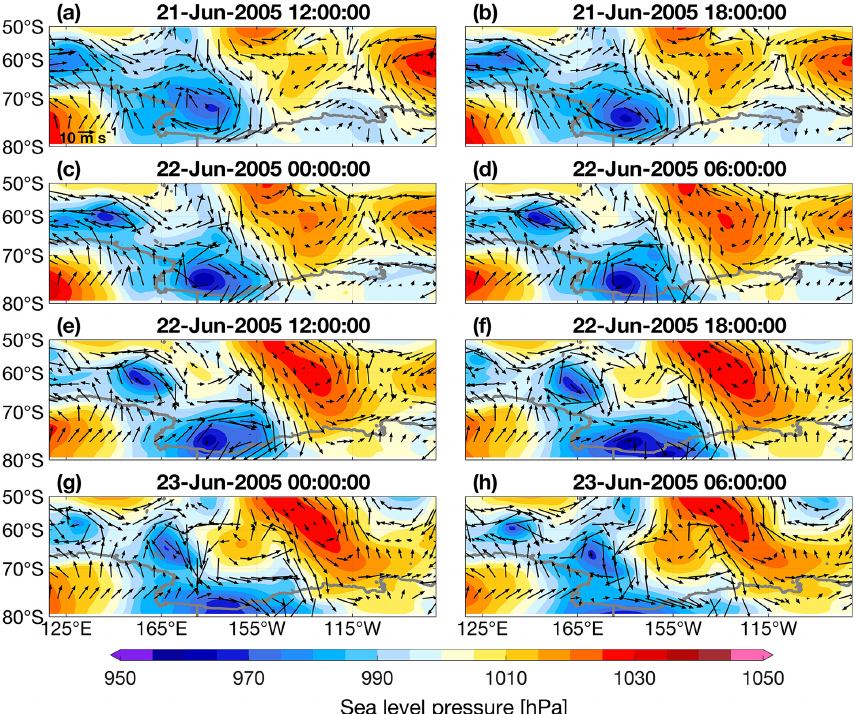
Figure 8. (a–h) Spatial distributions of 6h average sea level pressure (colored shading) and 10m wind vectors (black arrow) in the Ross Sea and surrounding regions over 21–23 June 2005.